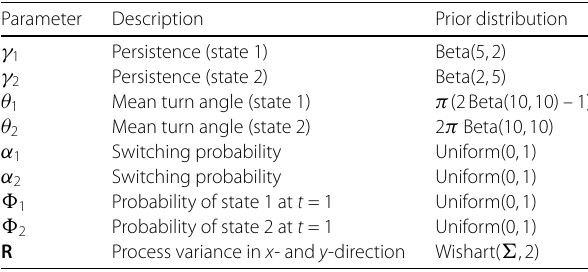
Table 5 Prior distributions for model parameters of the